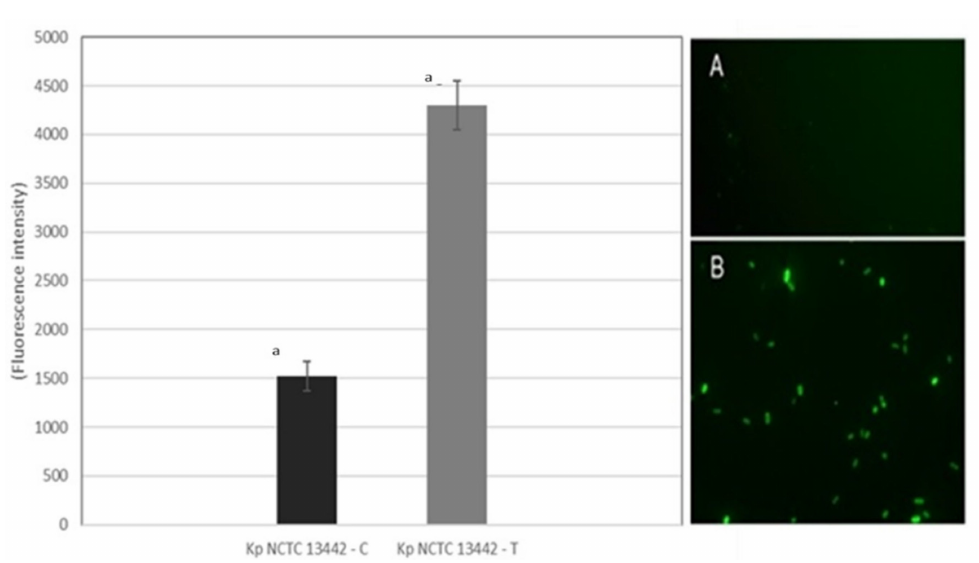
Figure 10. Measured fluorescence intensity for control and treated representative strain K. pneu- moniae NCTC 13442 biofilm. Results shown with median, minimum and maximum values. The lowercase letter a marks the statistically significant difference between the control and treated group of K. pneumoniae NCTC 13442 strain. On the right are fluorescence microscopy images magnified 1000 × of the control ( A ) and ozone-treated ( B ) representative strain K. pneumoniae NCTC 13442 biofilm. Excitation wavelength was 488 nm and emission were detected in the range of 500–600